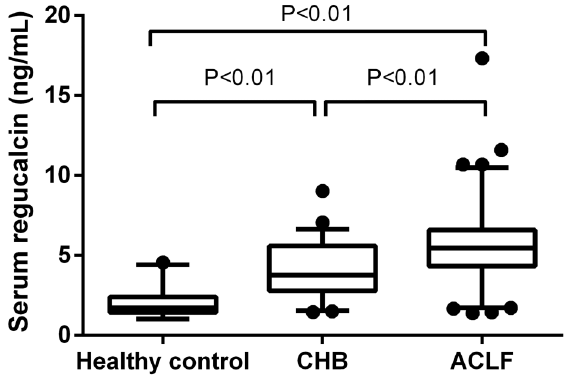
Figure 2. Serum regucalcin concentrations in heathy controls, and chronic hepatitis B (CHB) and acute-on-chronic liver failure (ACLF) patients. The top and bottom of each box represent the 25th and 75th percentiles. The line through the box is the median and the error bars represent the 5th and 95th percentiles. Statistical analysis was done with the Mann-Whitney